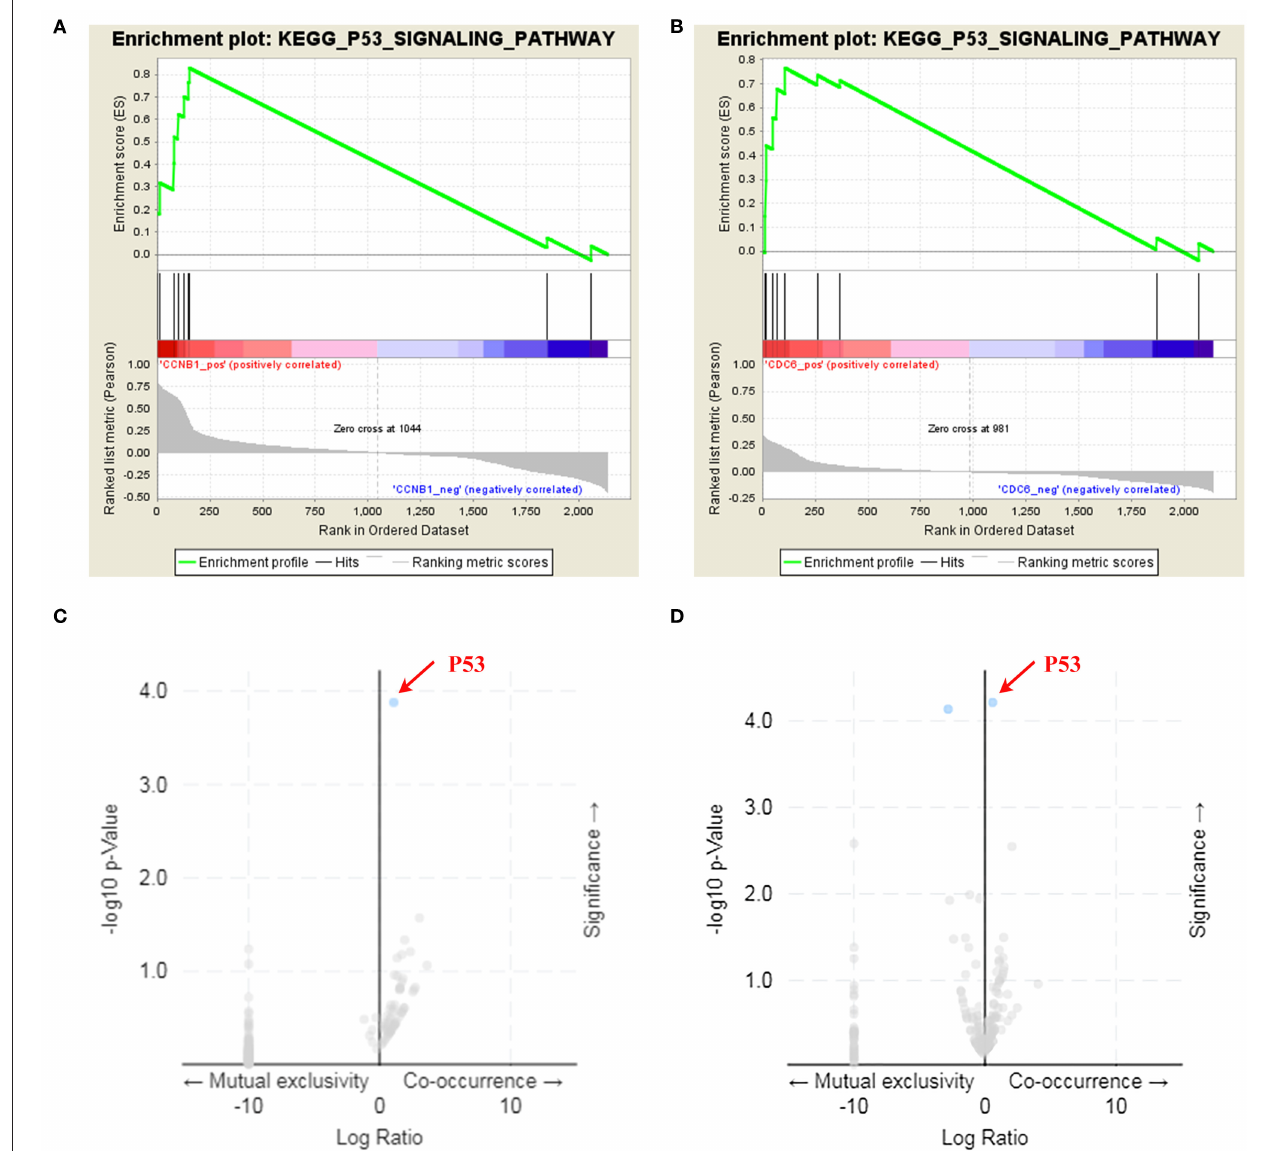
FIGURE 8 | GSEA enrichment analysis and co-mutation volcano plot for CCNB1 and CDC6. (A,B) Identification of the enriched genesets with GSEA analysis focused on a single gene as a phenotype. Over-representation of positive (NES = 1.778, p -Value = 0.004) and CDC6 (NES = 1.469, p -Value = 0.05) was associated with P53 signaling pathway. (C,D) Both CCNB1 ( p -Value = 1.323e-4, q -Value = 0.0229) and CDC6 ( p -Value = 6.106e-5, q -Value = 6.331e-3) showed a co-mutation with